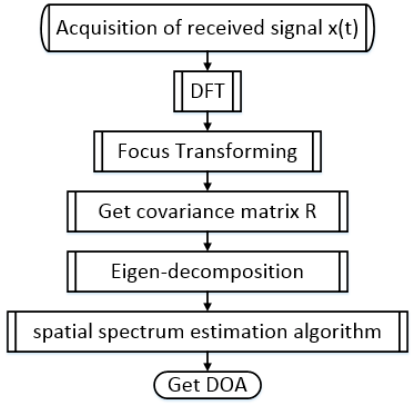
Figure 2. Flowchart of acoustic signal processing, DOA: direction of arrival; DFT: discrete Fourier transform.